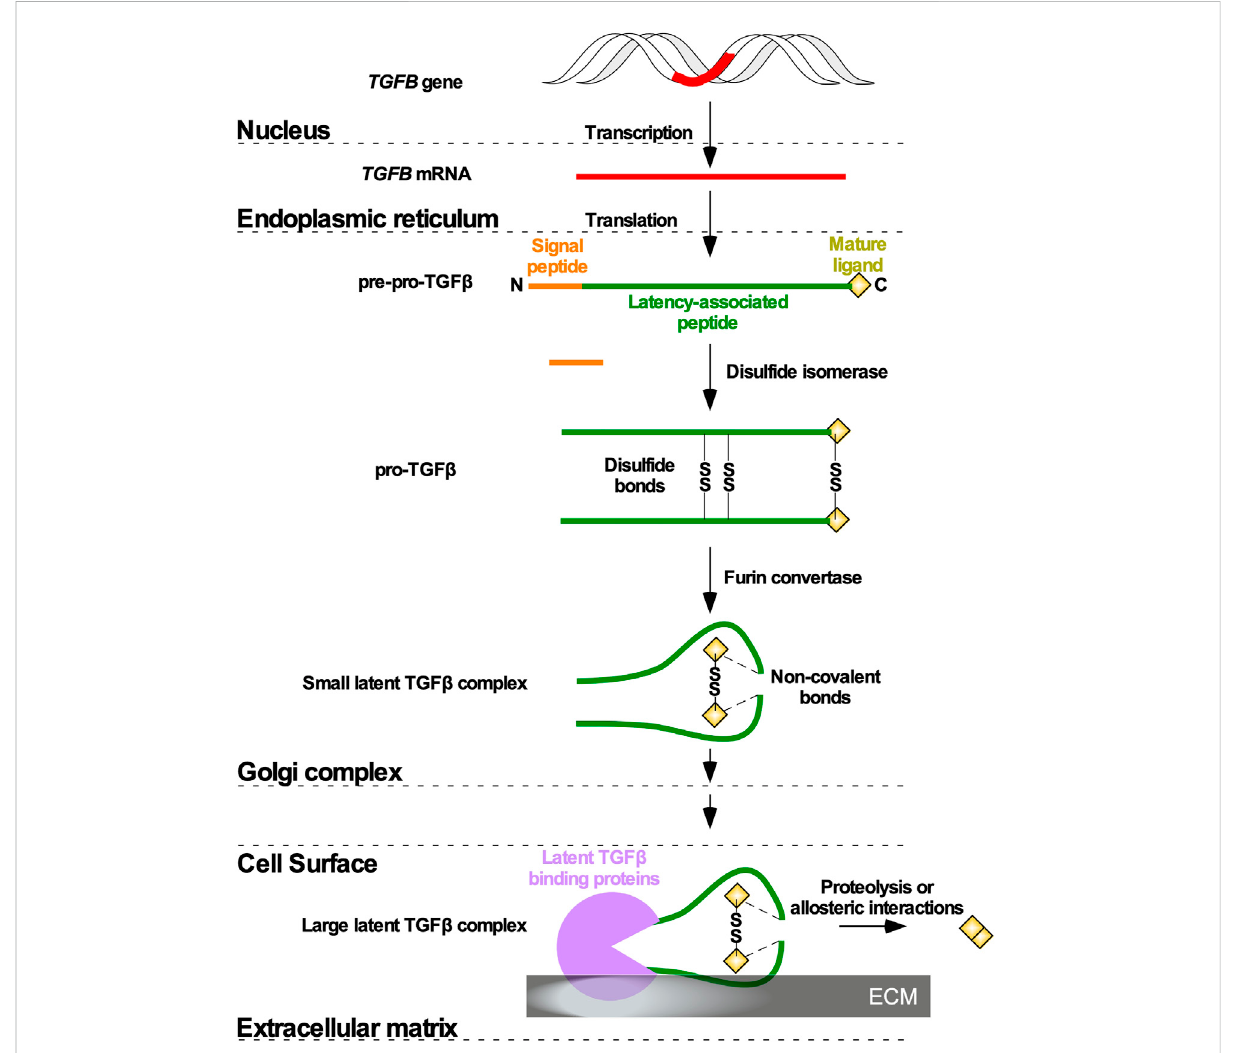
FIGURE 1 TGF β ligand maturation. Following Transforming Growth Factor- β ( TGFB ) gene (red) transcription and TGFB mRNA translation in the nucleus and endoplasmic reticulum, respectively, TGF β is synthesized as a precursor pro-TGF β (pre-pro-TGF β ). Pre-pro-TGF β contains an amino (N)- terminalsignal peptide latency-associatedpeptide,andmature ligand. TheN terminalsignal peptide ensurestransportation totheGolgicomplex.In the Golgi complex, the signal peptide is cleaved, and disul fi de isomerases catalyze disul fi de bonds (SS) between two pre-pro-TGF β monomers to generate pro-TGF β . Furinconvertasesmodify thelatency-associated peptides, which non-covalentlyassociatewithmatureligandsto generate a small latent TGF β complex. The small latent TGF β complex is secreted from the cell and attaches to latent TGF β binding proteins in the extracellular matrixtoformalargelatentTGF β complex.MatureligandsarereleasedfromthelargelatentTGF β complexes via allostericinteractionsorproteolysis mediated by